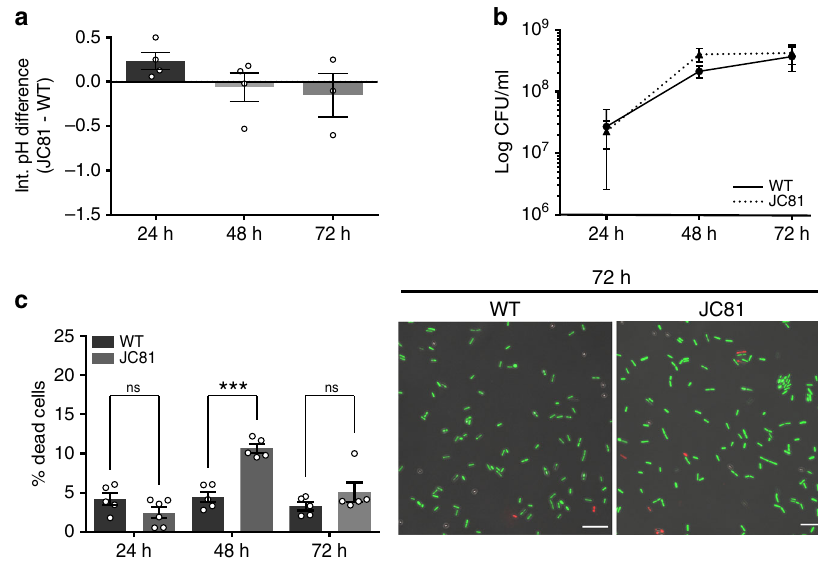
Fig. 10 The expression of the TasA variant prevents the increase of cell death. a Intracellular pH measurements of the WT and JC81 strains. Average values of four biological replicates are shown. Error bars represent the SEM. b Population dynamics (CFU counts) in WT and JC81 colonies. The WT data in Fig. 4C is from the same experiment as the data shown in this fi gure and is included here as a control in the comparison between the WT and JC81 strains. Average values of four biological replicates are shown. Error bars represent the SEM. c Left. Quanti fi cation of the proportion of dead cells in WT and JC81 colonies. N = 5 colonies of the corresponding strains examined over three independent experiments. Average values are shown. Error bars represent the SEM. For each experiment and sample, at least three fi elds-of-view were measured. Statistical signi fi cance was assessed via two-tailed independent t -tests at each time-point (*** p value = 0.0003). The WT data in Fig. 4 is from the same experiment as the data displayed in this fi gure and has been used as a control for the comparison between the WT and JC81 colonies. Right. Representative confocal microscopy images of fi elds corresponding to LIVE/DEAD- stained WT or JC81 cells at 72 hours. Scale bars = 10 µ m. Source data are provided as a Source Data fi